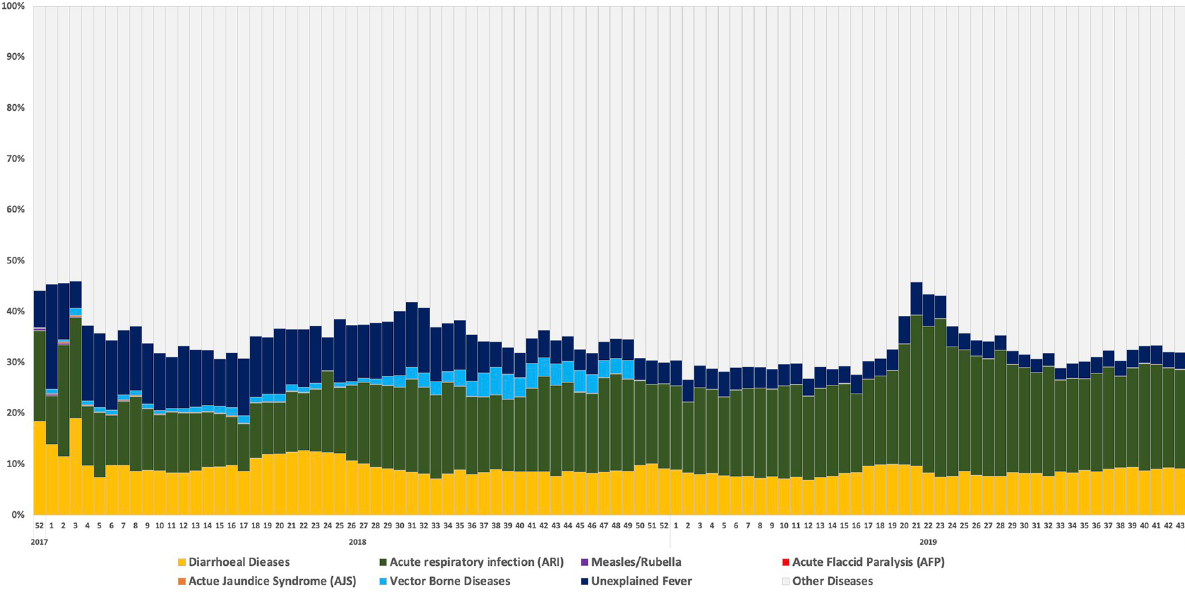
Fig 2. Cumulative trend in proportional morbidity for key diseases under EWARS surveillance from 1 January 2018–27 October 2019 [11].